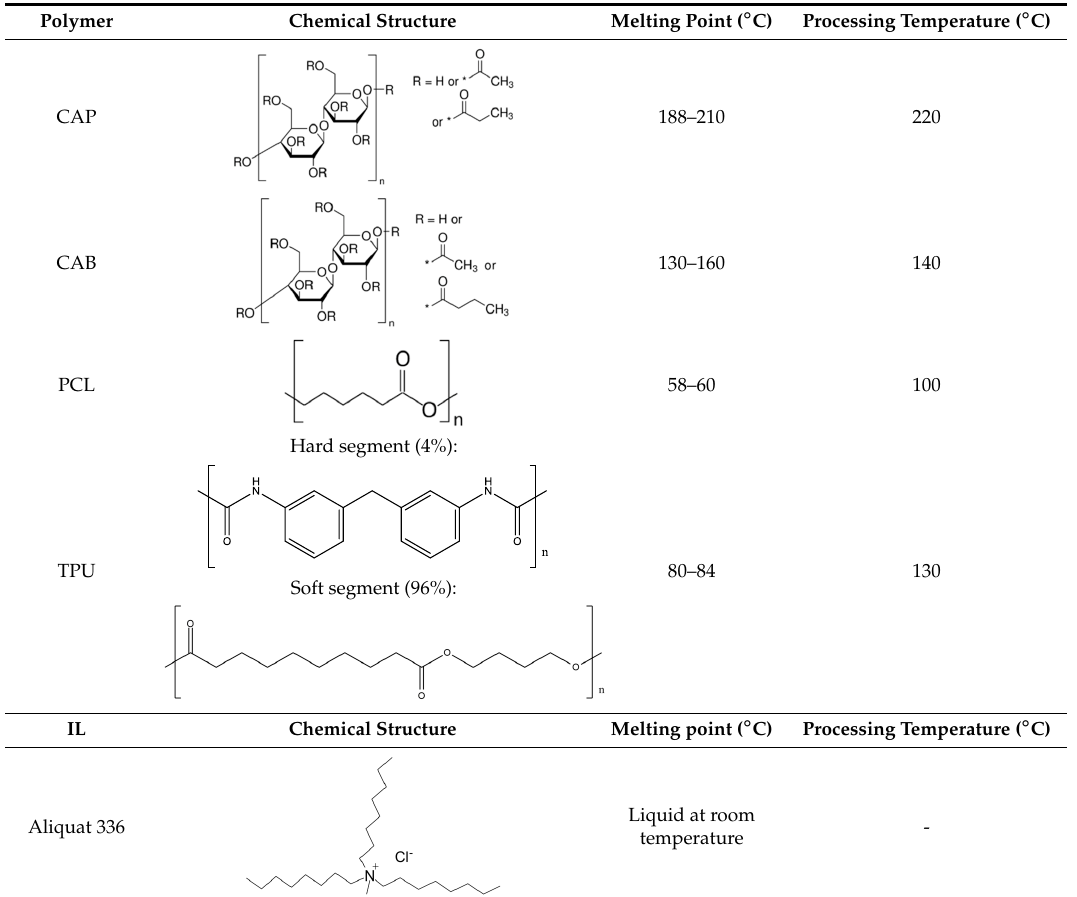
Table 3. Chemical structures, melting point and processing temperatures of the di ff erent polymers and the IL used for PIM preparation.